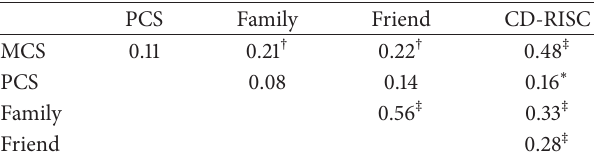
Table 2: Correlations among all independent variables and depen- dent variable ( 𝑁 = 198 ).